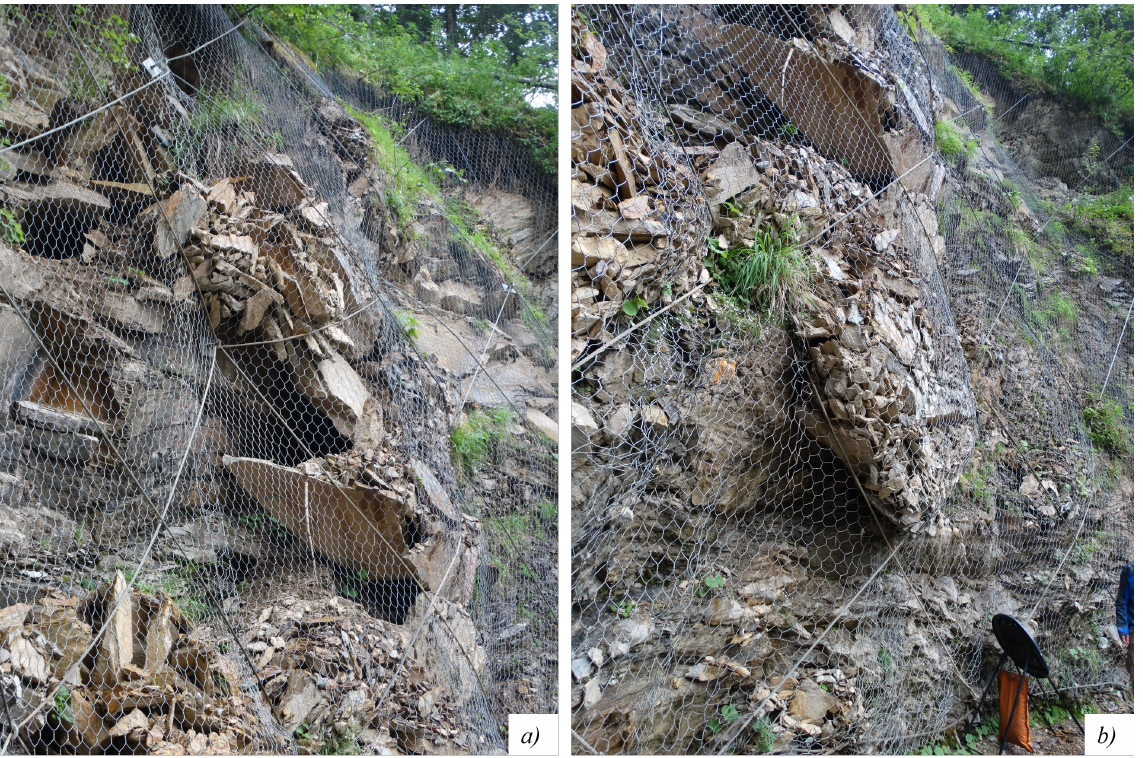
Figure 2. Beneficial effect of the ropes, which prevent failure diffusion near the anchors ( a ) and provide constraints for the mesh similar to those of standardized laboratory tests of UNI 11437 ( b